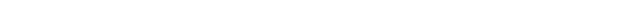
Fig. 2 Helraiser transposition from single- and double-stranded donors in human HEK cells. a Top: Helraiser transposition ef fi ciency from double-stranded (ds) and single-stranded (ss) transposon donors, measured by Puro -resistant colony formation in HEK293T cells. All data are presented as a mean ± s.e.m., n = 3 biological replicates. M marker, ds transfected ds donors, ss( + ) transfected plus-strand ss donors, ss( − ) transfected minus-strand ss donors. Middle: PCR detection of transfected ds and ss transposon donors. All PCRs are performed with low-molecular weight (LMW) DNA isolated 48 h post- transfection. Bottom: schematic of the relevant portions of Helraiser donor (pHelR-CMV-Puro) and helper (pFHelR) plasmids. All plasmids are used in closed, circular form unless otherwise stated. Uncropped gel image is provided in Supplemental Fig. 1a. b Top: Helraiser transposition ef fi ciency from ds, ss ( + ), and ss( − ) transposon circles, as measured by Puro -resistant colony formation in HEK293 cells. ds transfected ds transposon circles, ss( + ) transfected plus-strand ss transposon circles, ss( − ) transfected minus-strand ss transposon circles. Middle: PCR detection of transfected ds and ss transposon circles. Bottom: schematic of the Helraiser circle (pHelRC-Puro) and helper (pFHelR) plasmid. Uncropped gel image is provided in Supplemental Fig. 1a. c Helraiser junction formation from ds and ss transposon donors. Left: outline of the CD-PCR method. Red arrows: forward (fwd) and reverse (rev) primer binding sites; dashed red line: fi rst PCR cycle ampli fi cation products; dashed red arrows: primer binding sites on ampli fi ed products; full red line: fi nal ds ampli fi cation product. Right: junction detection by CD-PCR. C no template control. Co-transfection of transposon donors with transposase helper plasmids is indicated as pFHelR “ + . ” pFHelR “ − ” indicates co-transfection with control plasmids. d SS-TJD PCR of transposon circles. Lanes 1 – 5: PCR detects plus strand. Lanes 6 – 10: PCR detects minus strand. In lane 6, two sequenced PCR products containing Helraiser end junctions are indicated. Bottom: positions of the aberrant cleavage sites on the transposon donor molecule prior to end joining are indicated. e SS-PCR of transposon donors. Lanes 11 – 13, PCR detects plus strand; lanes 15 – 17, PCR detects minus